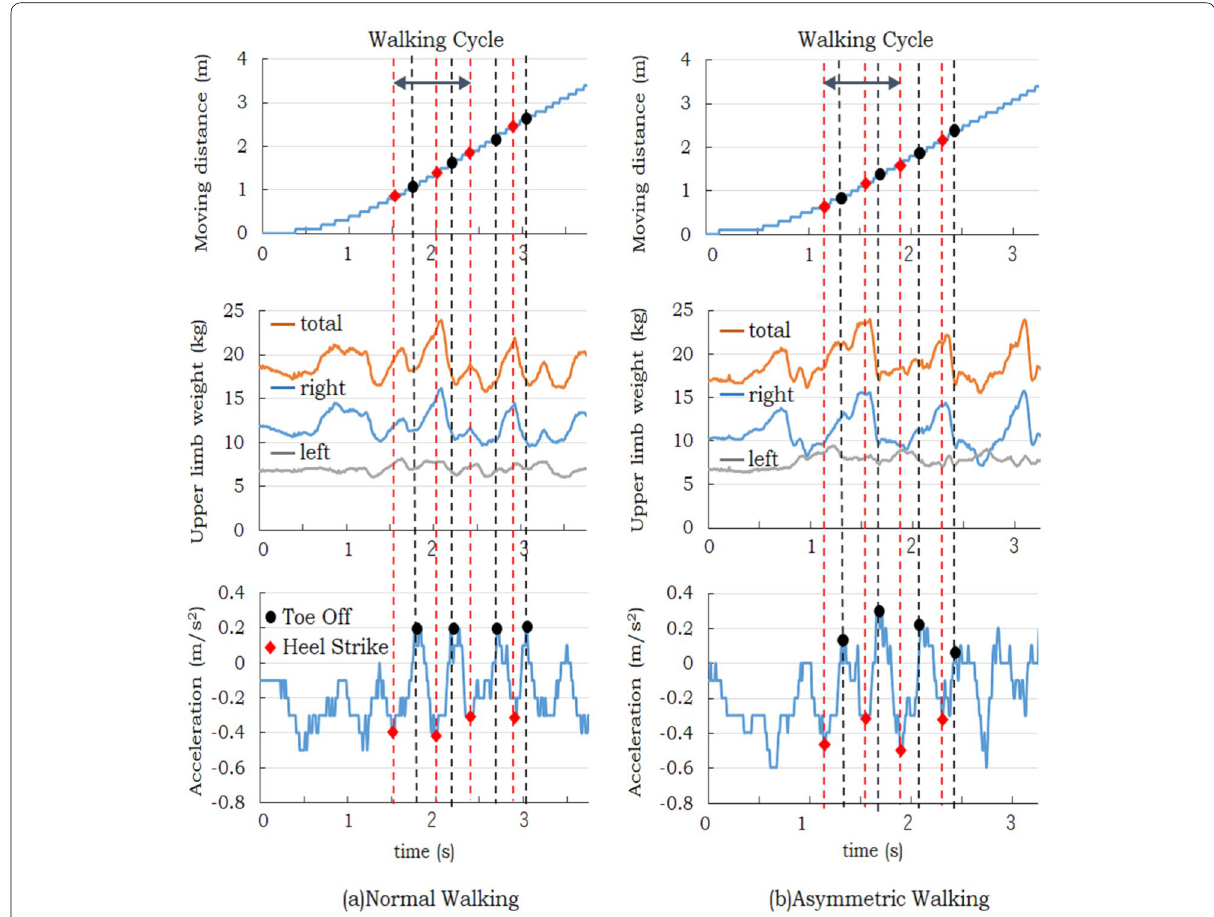
Fig. 13 Measurement result for a target rUW of 40%— a normal walking and b using footwear with the 4 cm block on the sole of the right